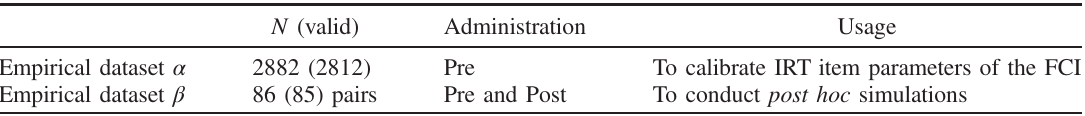
TABLE I. Empirical datasets and their usage. N